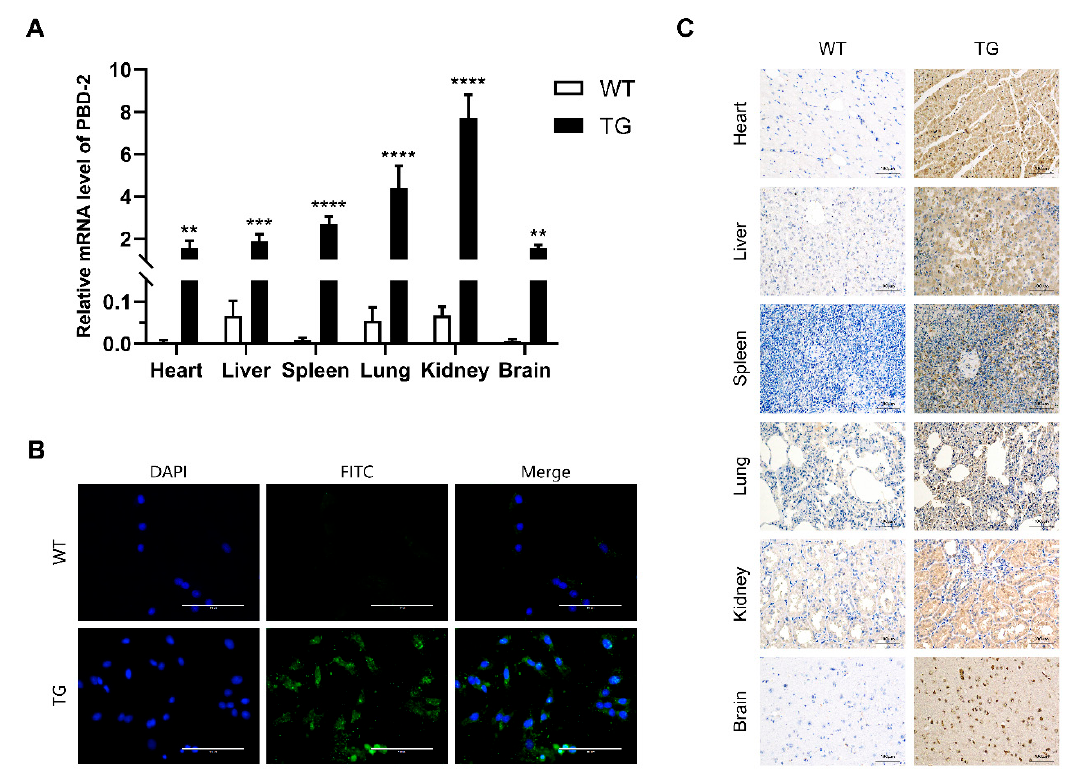
Figure 4. Transcriptional and translational analysis of pbd-2 in cloned pigs. ( A ) The mRNA expression level of pbd-2 in different organs. Total RNA in different organs of TG and WT pigs was extracted and then subjected to reverse transcription, followed by RT-qPCR to determine the mRNA level of pbd-2 , GAPDH was used as an internal reference gene. Data are presented as mean ± SD and are plotted from three independent experiments. ** p < 0.01, *** p < 0.001, **** p < 0.0001, n = 3, unpaired one tailed Student ′ s t -test. ( B ) Immunofluorescent analysis of the expression of porcine β -defensin 2 (PBD-2) using a 40× objective and a 100 ms exposure. The expression of PBD-2 in PEFs from TG pigs was detected by immunofluorescent analysis using mouse monoclonal anti-PBD2 antibody followed by FITC-labeled goat anti-mouse IgG. Cell nuclei were stained with 4 ′ ,6-diamidino-2-phenylindole, the PEFs from WT pigs served as a negative control. Scale bar = 100 μ m. ( C ) Immunohistochemical analysis of the expression of PBD-2 at a magnification of 200×, with an exposure time of 50 ms. Expression of PBD-2 in heart, liver, spleen, lung, kidney and brain tissues of WT and TG pigs was determined by immunohistochemistry using mouse monoclonal 2A peptide antibody. Brown color represents the detected 2A peptide, which is co-expressed with PBD-2. Scale bars = 100 μ m.